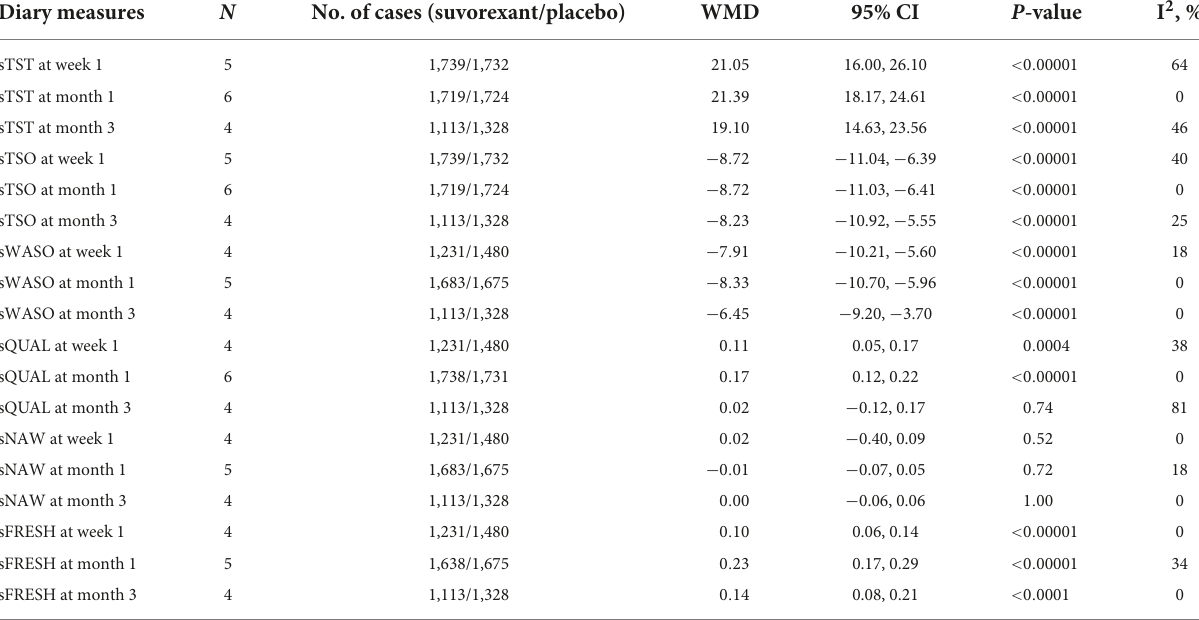
TABLE 2 The mean changes of efficacy outcome (diary measures) results from baseline in suvorexant vs. placebo. Diary